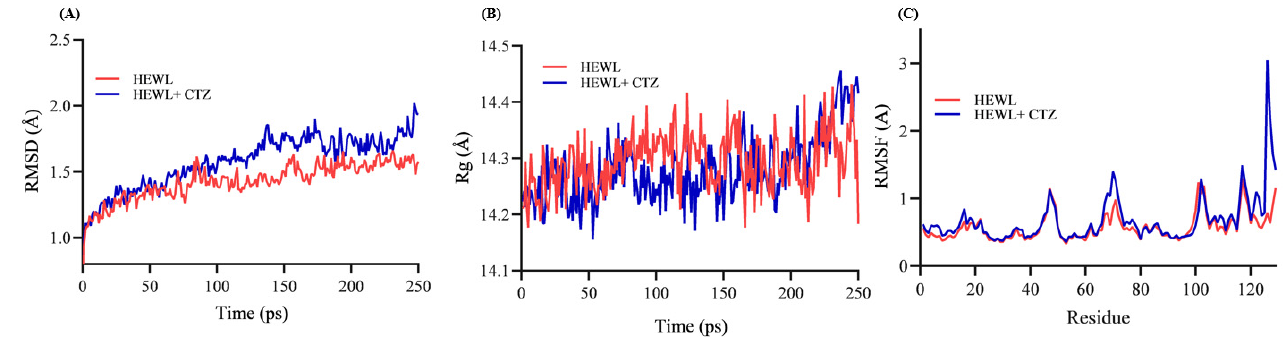
Figure 10. MD simulation equilibration and analysis of the stability of free and bounded HEWL. ( A ) Time evolutions of backbone RMSD of free and CTZ-bounded HEW. ( B ) The Rg of free and CTZ bounded HEW. ( C ) The RMSF of free and CTZ-bound HEW.